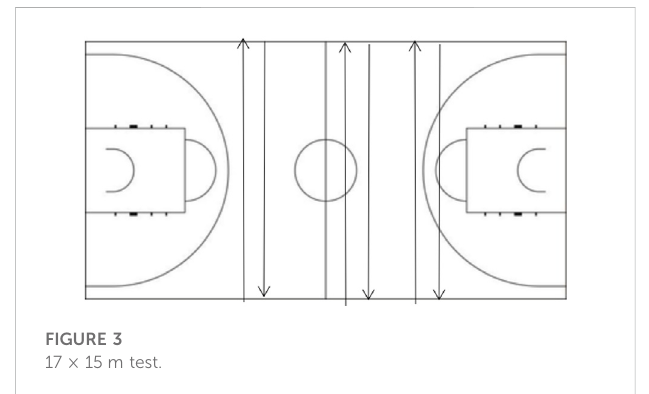
FIGURE 3 17 × 15 m